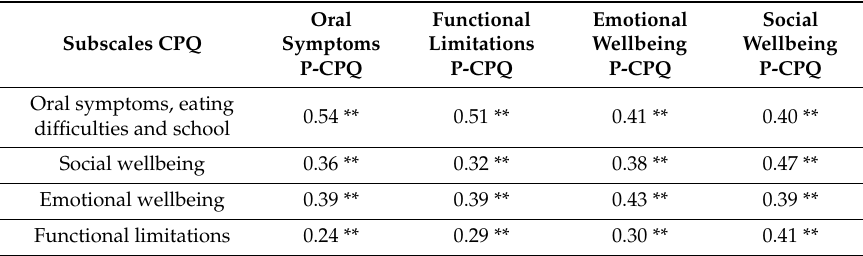
Table 4. Correlation between the subscales of the Hindi translation of CPQ 11–14 and P-CPQ demonstrating convergent validity.